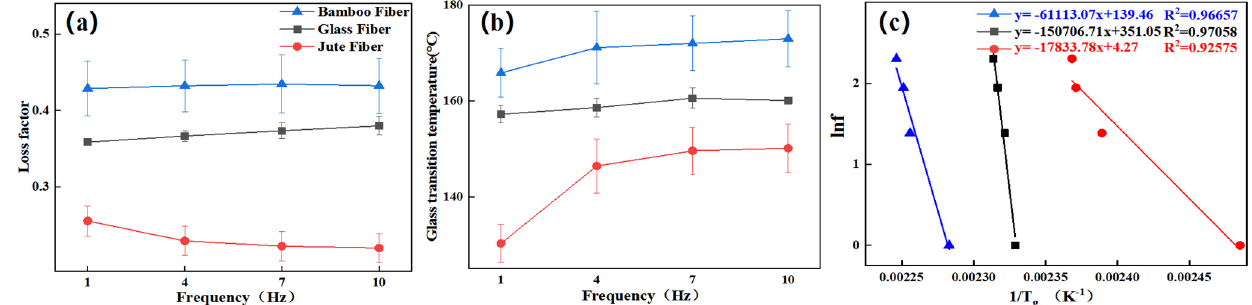
Figure 10. Loss factors and glass transition temperatures of circumferential composites at different frequencies: ( a ) loss factor vs. frequency; ( b ) Tg vs. frequency; ( c ) apparent activation energies of circumferential composites.